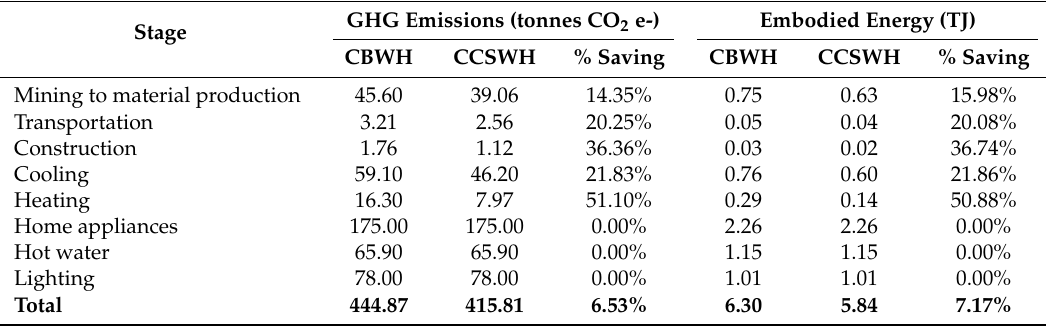
Table 3. Breakdown and comparison of GHG emissions and embodied energy consumption in terms of inputs for CBWH and cast in-situ sandwich wall house (CCSWH).